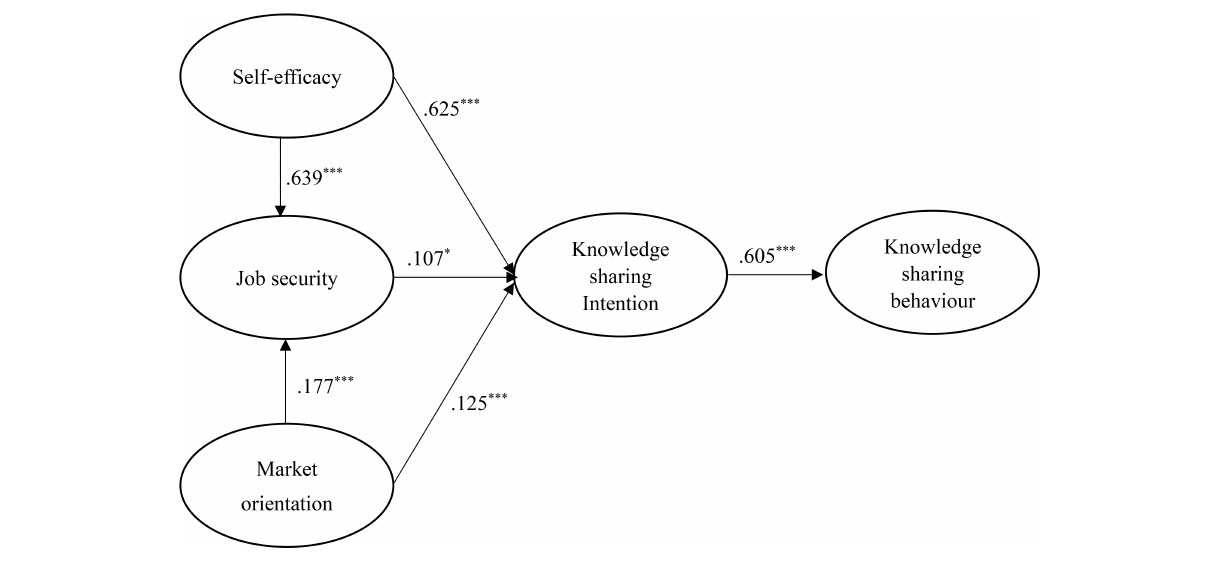
supporting H2. Moreover, self-efficacy ( β MainlandChina =